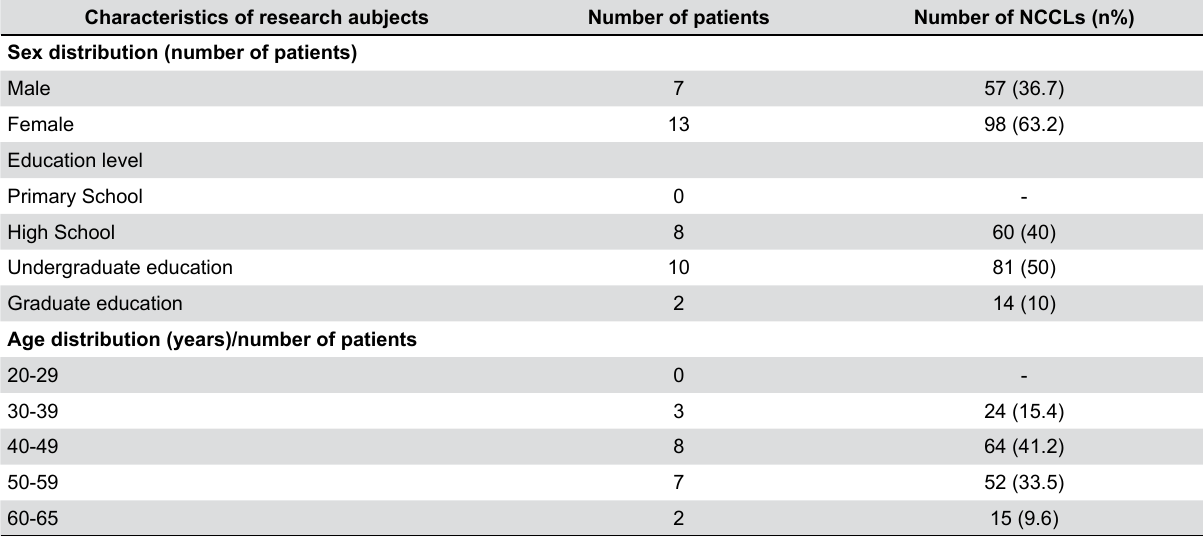
Table 1- Distribution of treated research subjects and non-carious cervical lesions according to sex, age and education level